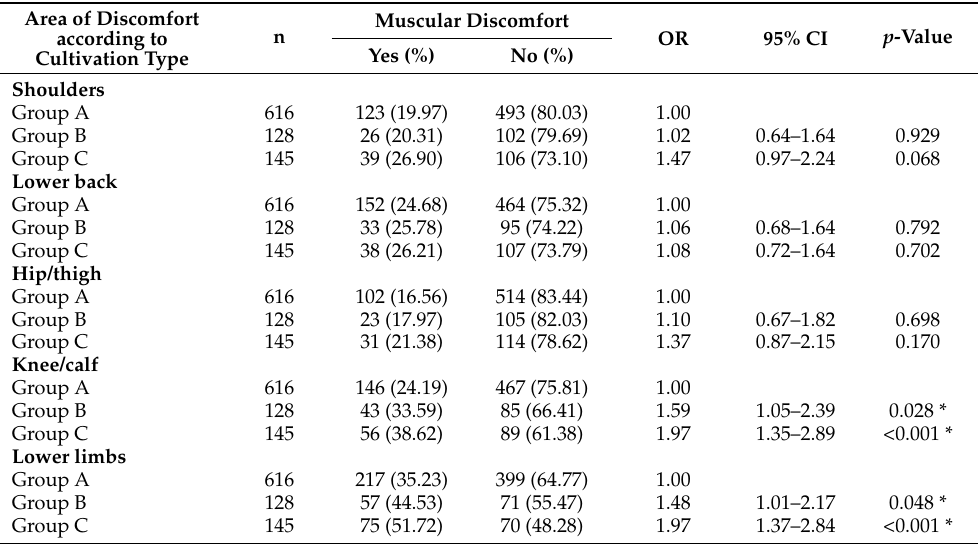
Table 2. The association between cultivation type and muscular discomfort shown by simple logistic regression (n = 889).